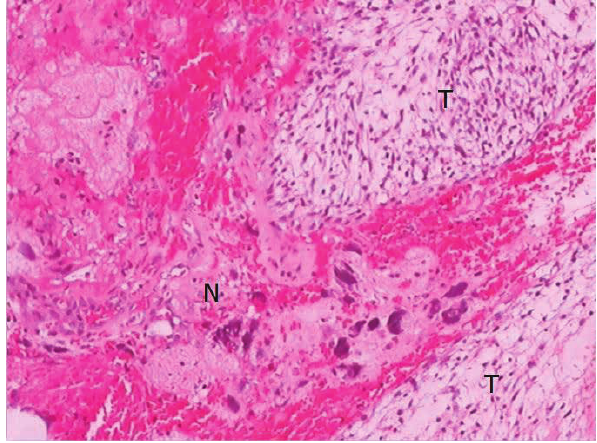
Figure 1: Histopathological slide of the first surgery of this patient. The oviduct smooth muscle cell area had been invaded by pleo- morphic cells, in particular, spindle cells. N indicates necrosis of the oviduct smooth muscle area; T: tumor area, which contained multiple spindle